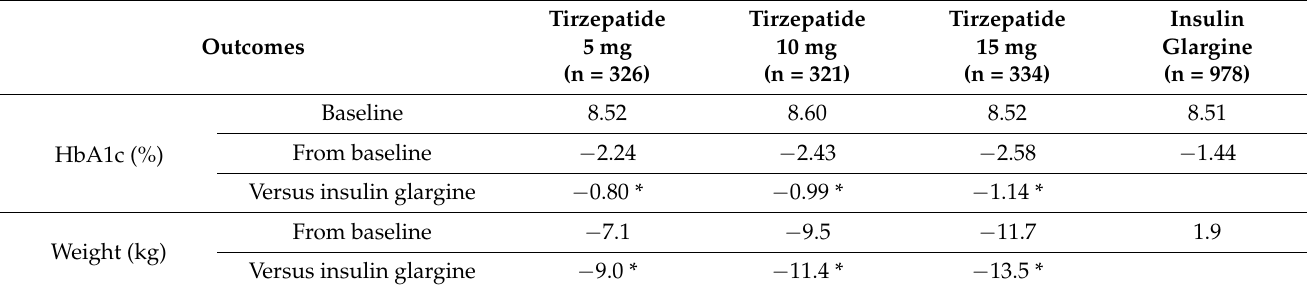
Table 4. Results of the SURPASS-4 trial at 52 weeks [52]. Efficacy analyses were performed in the mITT population; * p <